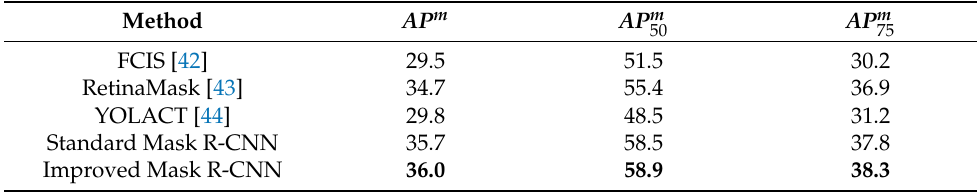
Table 3. The instance segmentation results on